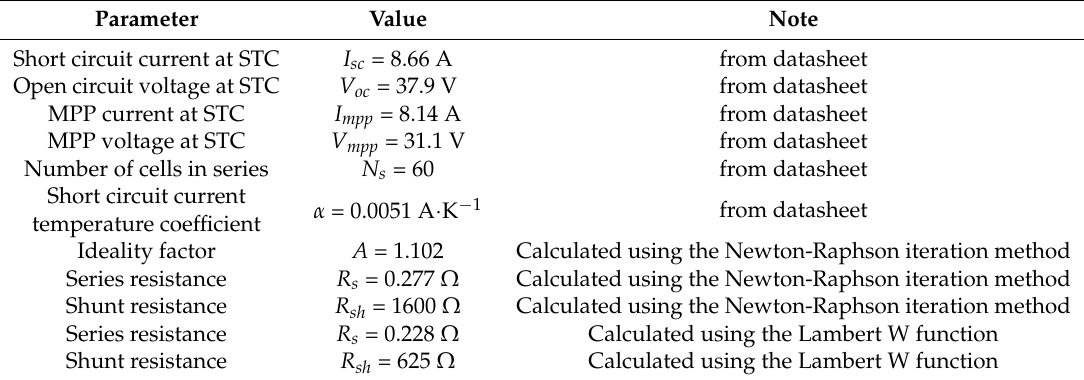
Table 1. Parameters of simulated photovoltaic (PV) panel. Standard Test Conditions (STC); MPP: maximum power point.